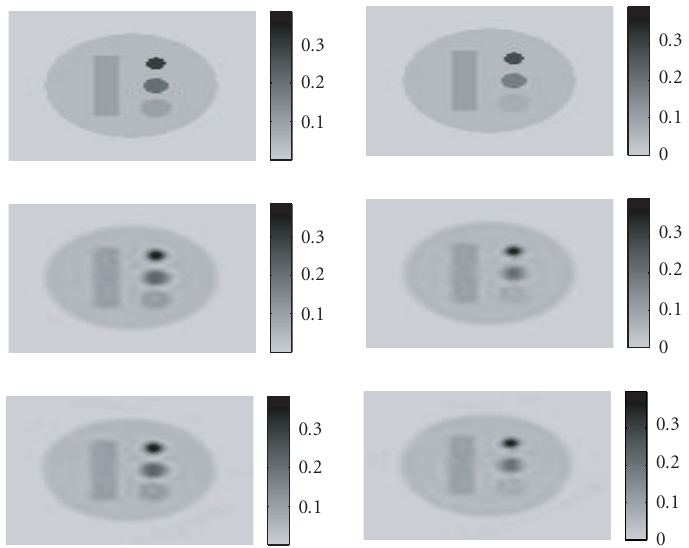
Figure 2: Reconstruction of a complex-valued